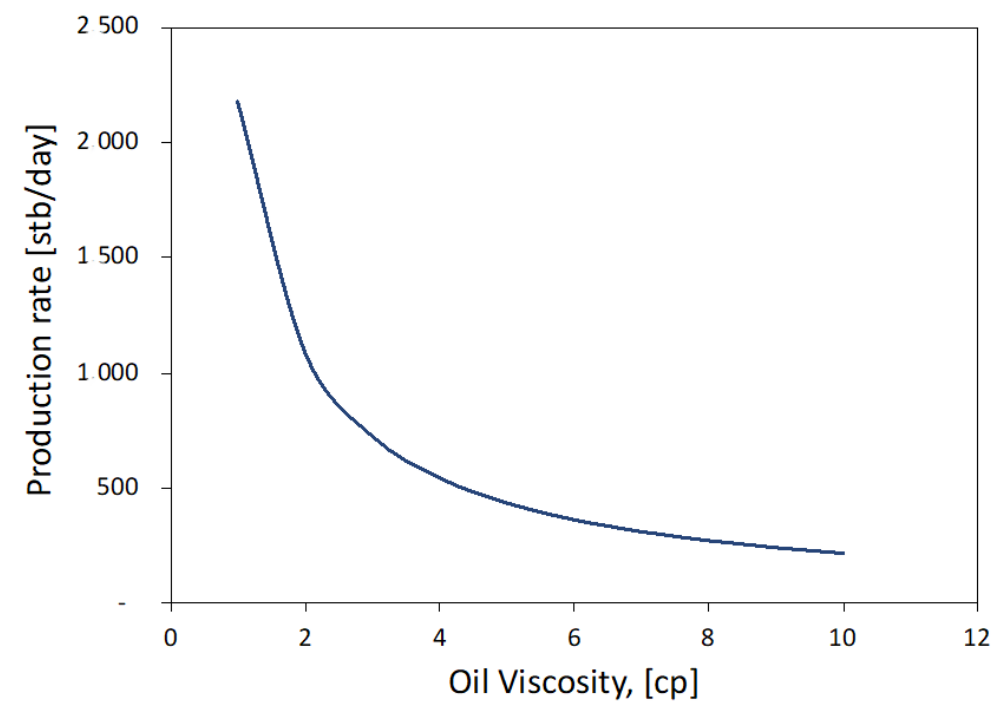
Figure 15. Modeled effect of oil viscosity on production rate (Well #1).